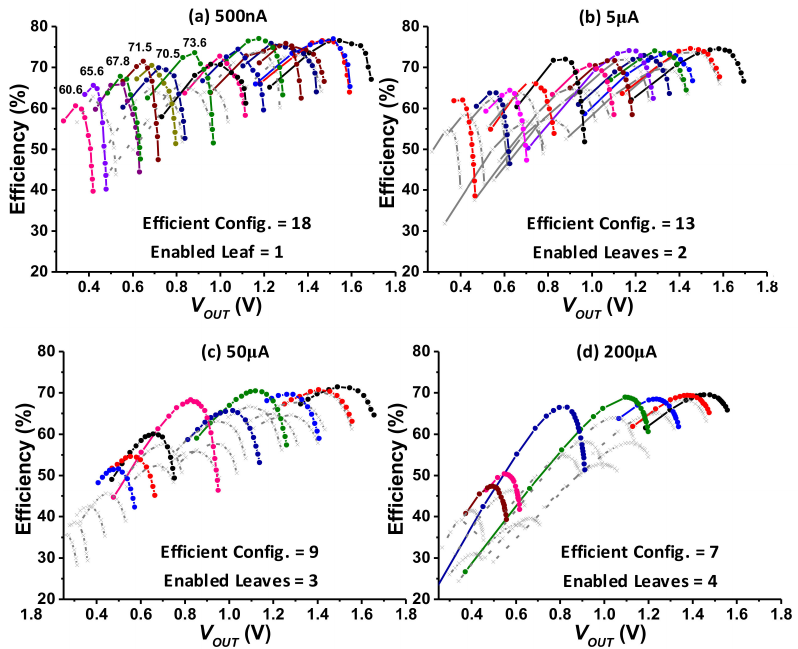
Figure 22. Multi-ratio, multi-leaf SC converter’s efficiency curves at I LOAD ( a ) 500 nA. ( b ) 5 µ A. ( c ) 50 µ A. ( d ) 200 µ